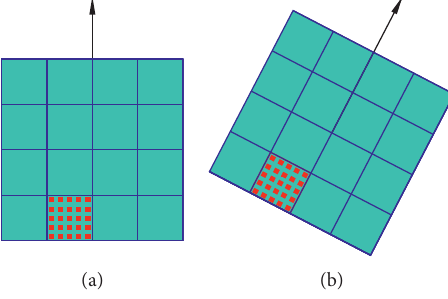
Figure 9: The generation of feature point